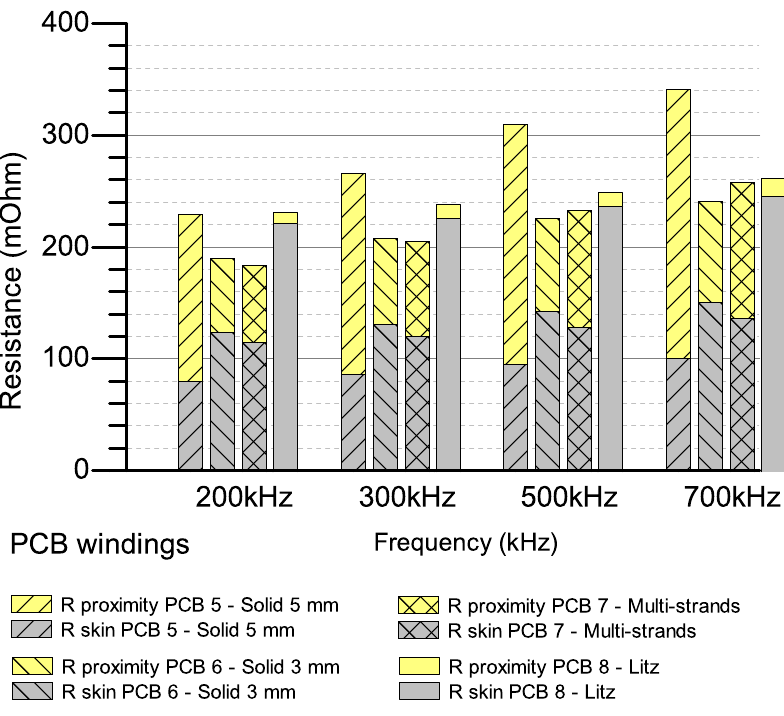
Figure 17. Calculated skin and proximity resistances 7-turn windings.